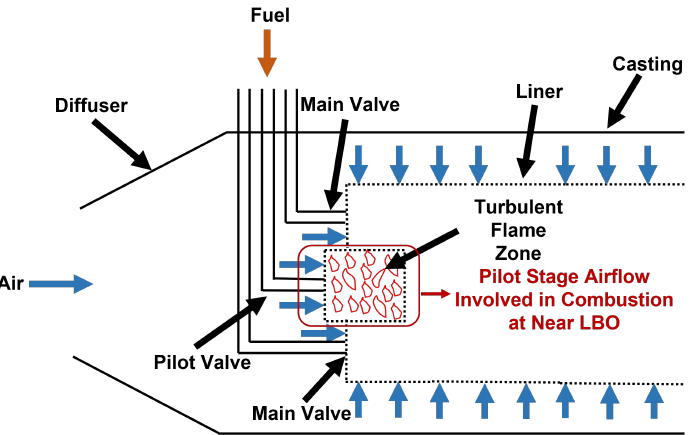
Figure 6. LBO MPLDI combustor flow pattern schematic [36].